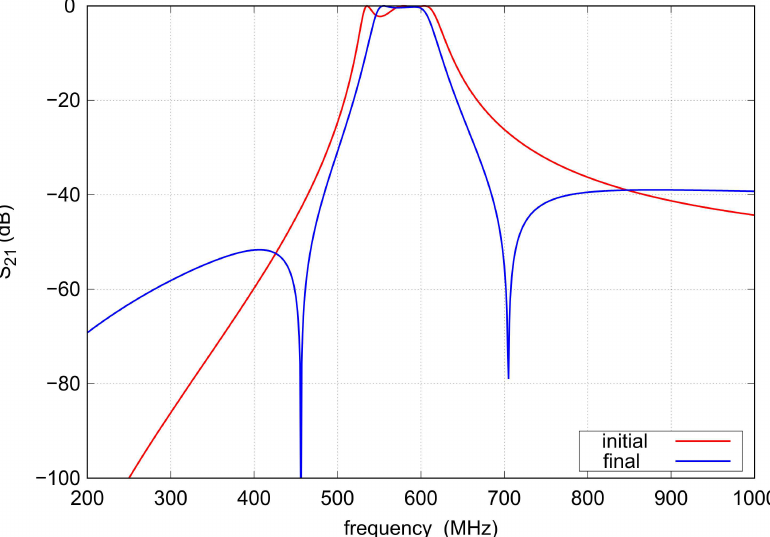
Figure 4. The s 21 parameter of the lumped element bandpass filters shown in Figure 1 ( k = 0.2, C = 5.5